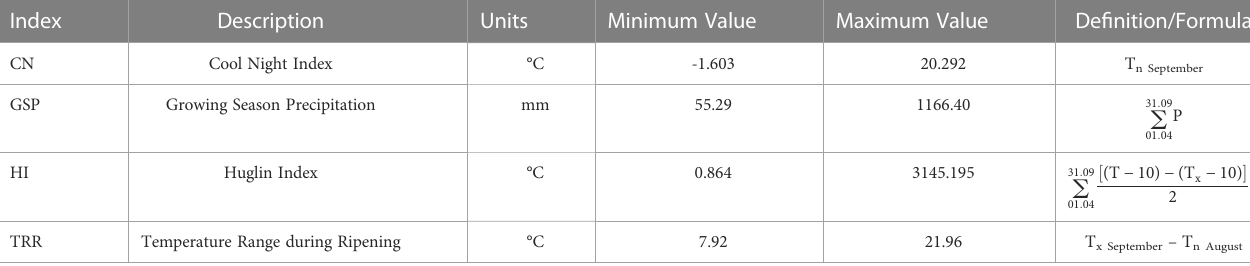
TABLE 1 - List of bioclimatic